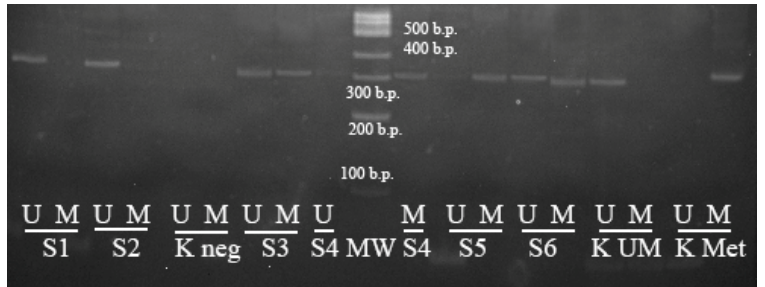
Figure 4. Results of the methyl-specific PCR to determine the methylation status of the MIR-203 gene (electrophoresis in 5% polyacrylamide gel, M—PCR with primers specific for the methylated allele, UM—PCR with primers specific for the unmethylated allele). K Met—control methylated DNA, K UM—control unmethylated DNA, K neg—negative control, S1–S6—samples of DLBCL patients, MW—100 bp molecular weight marker.